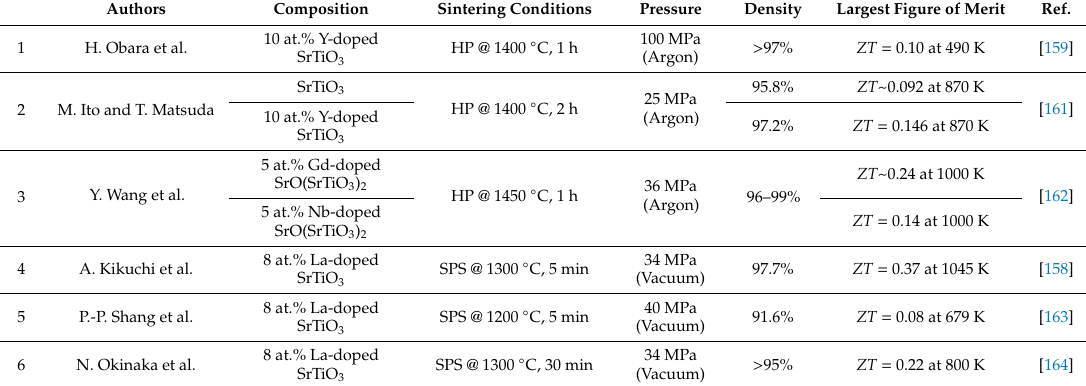
Table 2. Lists the hot pressing (HP) and spark plasma sintering (SPS) parameters employed to prepare SrTiO 3 -based ceramics reported in the literature by several